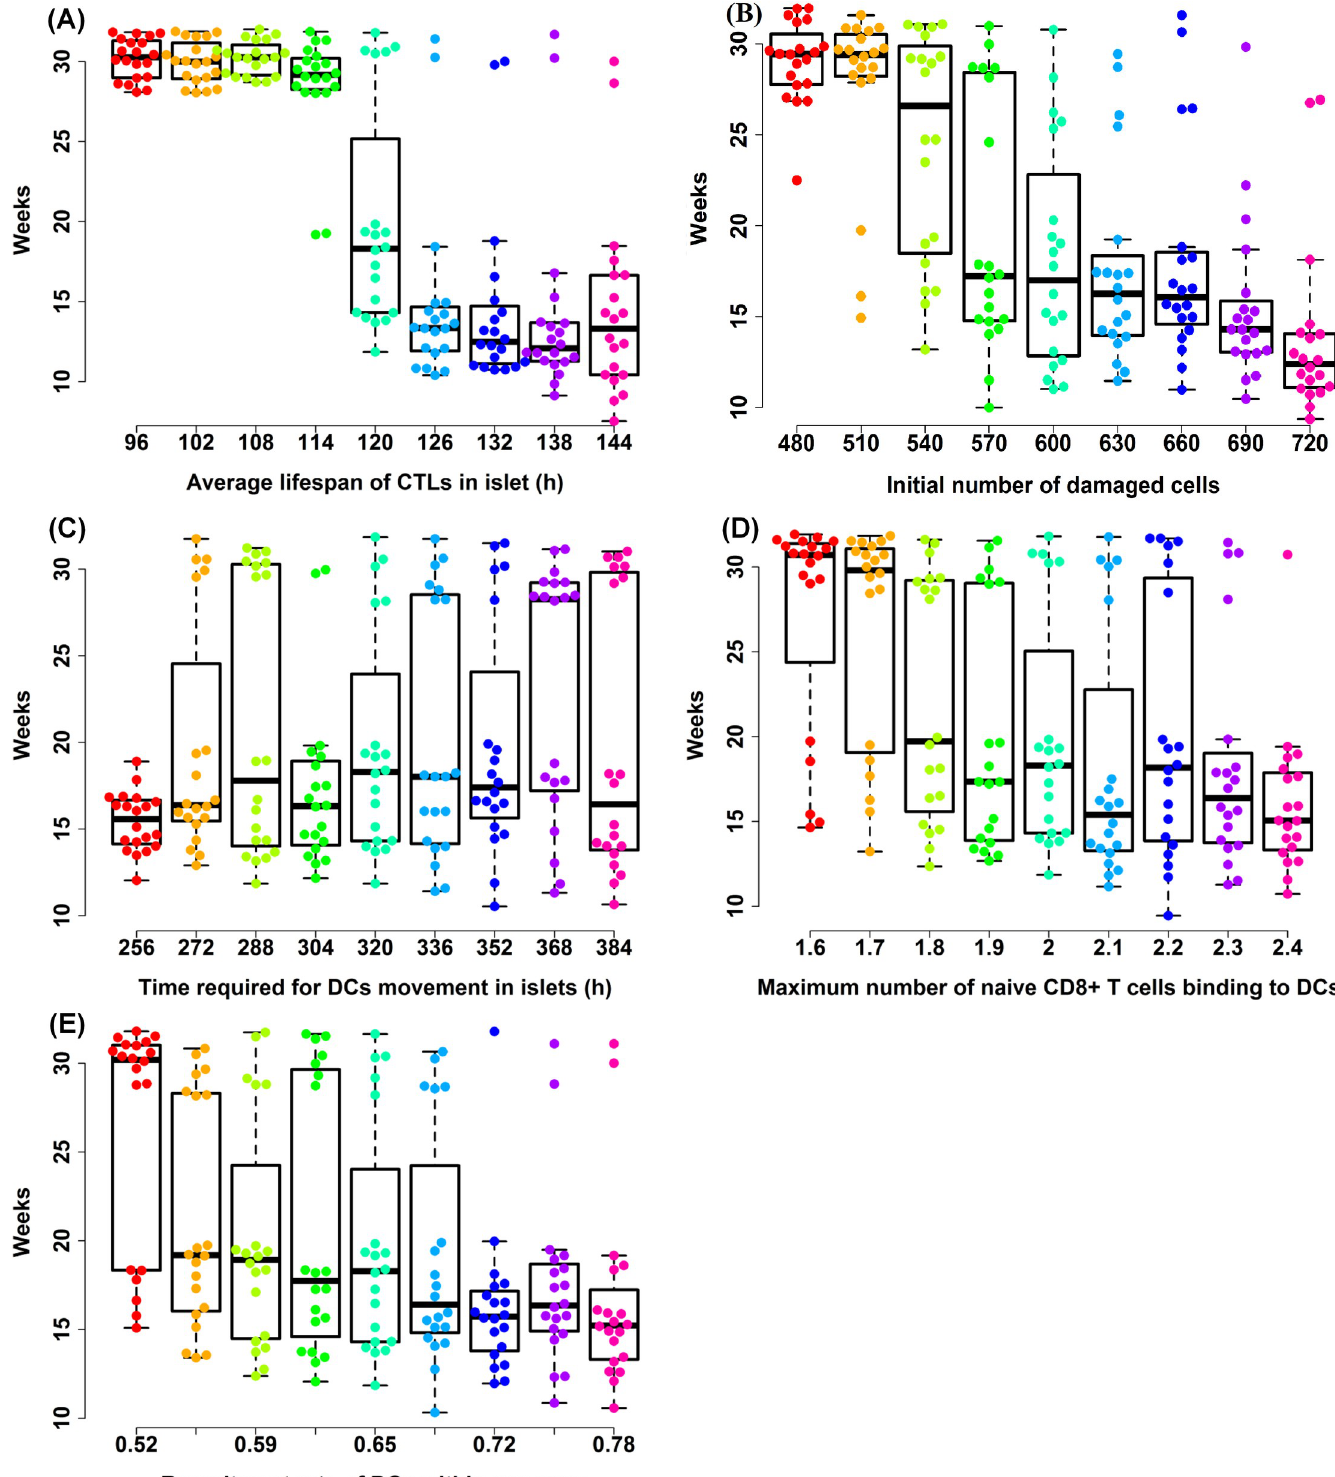
Fig 6. Discernible fluctuation in time required for developing overt T1D based upon selected values of parameters using local sensitivity analysis. (A-E) The horizontal axes represent selected values of five input parameters in the spectrum of [P d ± 30% × P d ], and the vertical axes denote the time required for developing T1D. Box plots and raw data illustrate heterogeneities occurring during T1D for selected values. The black dashed lines outline the lower and upper whiskers and black solid